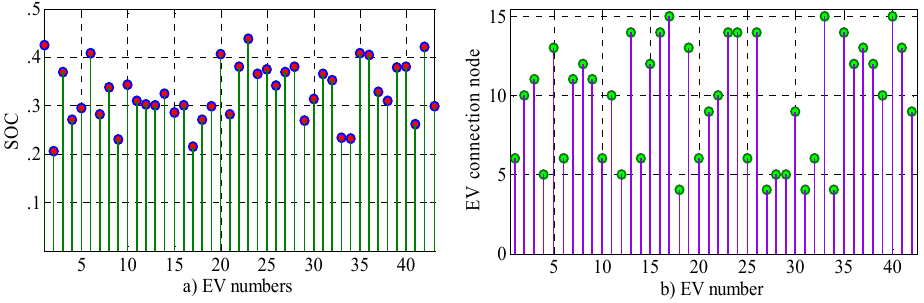
Figure 8. Distribution of: ( a ) initial SOC ; and ( b ) EV connection nodes, for each EV.